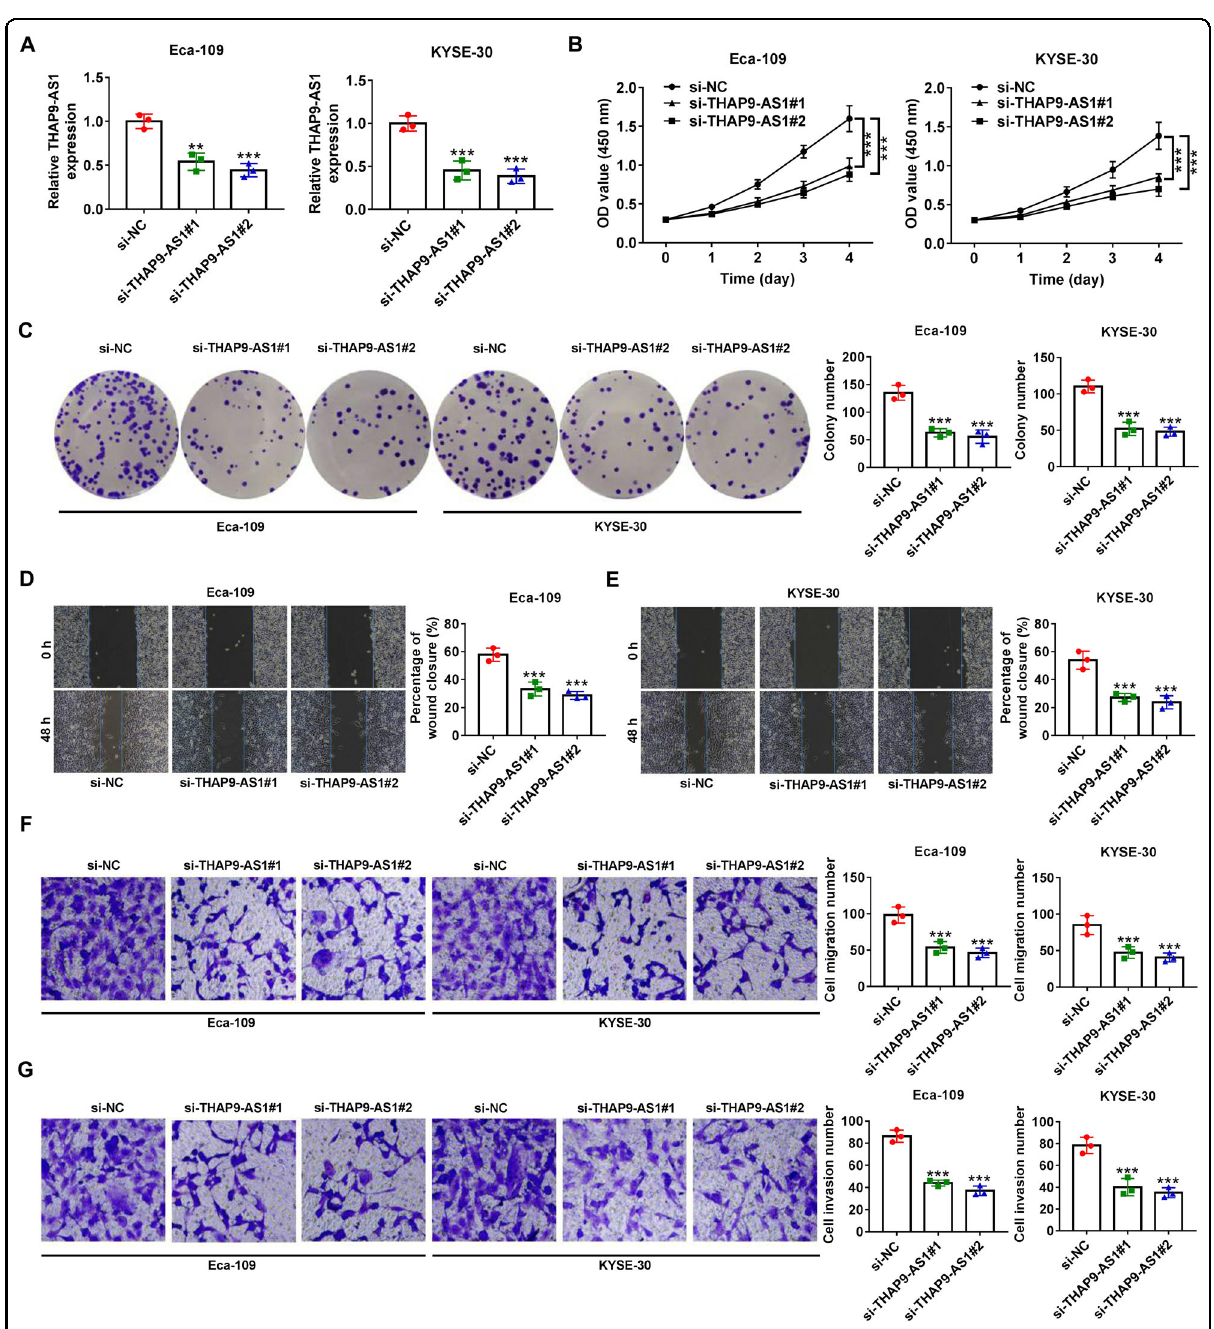
Fig. 2 THAP9-AS1 promotes ESCC cell proliferation, migration, and invasion in vitro. A qRT-PCR was applied to detect the transfection ef fi ciency of si-RNAs targeting THAP9-AS1 (si-THAP9-AS1#1 or si-THAP9-AS1#2) in Eca-109 and KYSE-30 cells. B and C CCK-8 and colony formation assays were used to assess the effect of THAP9-AS1 depletion on cell proliferation. D and E A wound-healing assay were conducted to detect the in fl uence of THAP9-AS1 knockdown on ESCC cell migration capability. F and G Transwell assays were employed to evaluate the migration and invasion abilities of Eca-109 and KYSE-30 cells with THAP9-AS1 knockdown. ** P < 0.01, *** P <